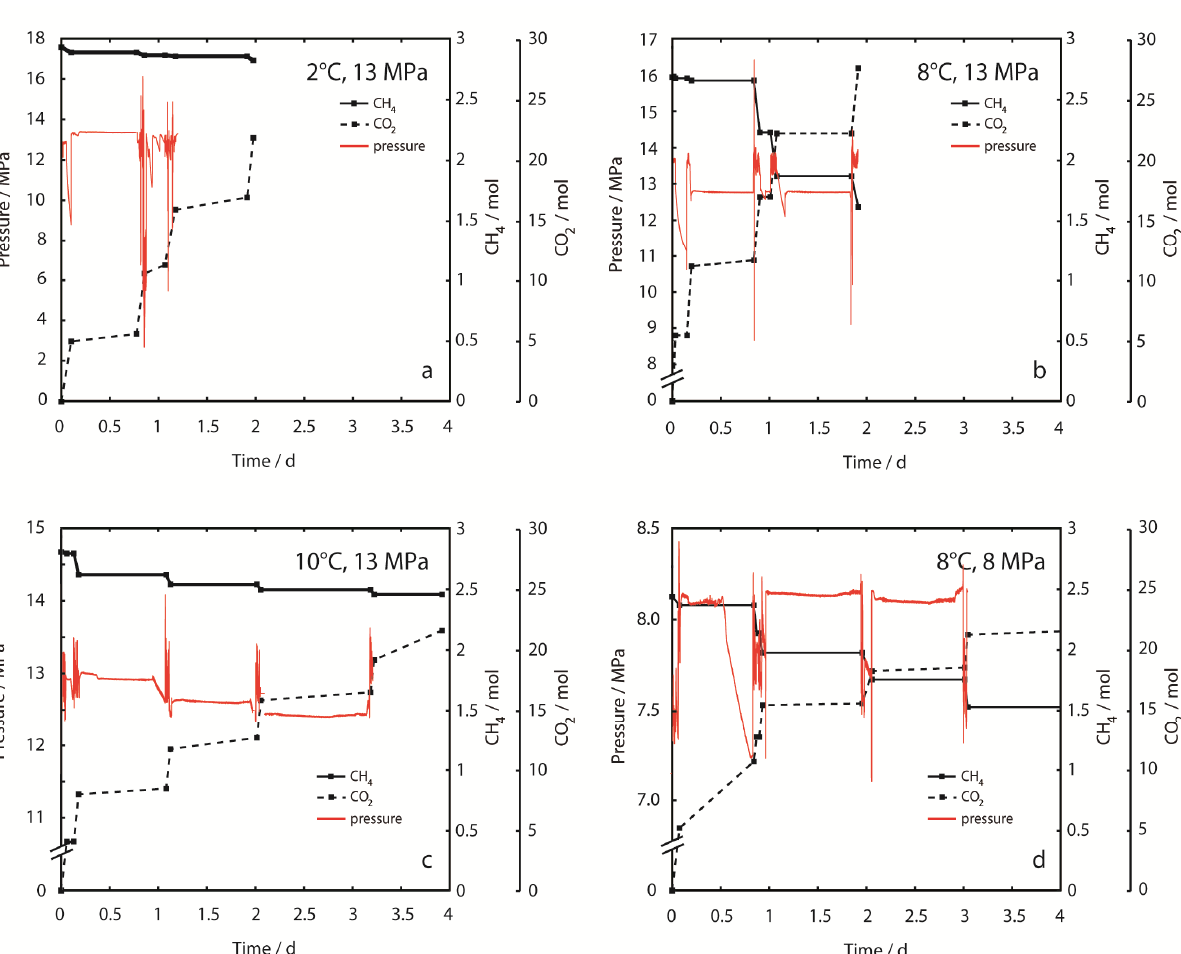
Figure 3. Inventory of CH , cumulative amount of injected CO and sample effluent pressure 4 2 ( p ) in each of the experimental runs. ( a ) 2 °C, 13 MPa; ( b ) 8 °C, 13 MPa; ( c ) 10 °C, effl 13 MPa; ( d ) 8 °C, 8 MPa. It should be noted, that the axis scaling for p is different for effl every experiment. CO was injected stepwise as hot supercritical CO and at a constant 2 2,sc flow rate (steep gradients in dashed lines). Injection of CO at constant pressure and low flow 2 rate alternated with equilibration periods. Fluids including CH could only exit the system 4 during injection/production periods. CH production is shown as a decrease of the CH 4 4 inventory. Effluent fluid pressure ( p ) is constant during equilibration periods. Strong effl aberrations indicate technical problems, which could be solved without destabilization of the hydrate sample. However, p is unstable during injection periods. Massive pressure spikes effl were observed in Experiment 1 (2 °C, 13 MPa) after sample permeability changed due to CO -hydrate formation. Sample permeability could be restored temporarily by fracturing at 2 high differential pressures (>15 MPa). CO -hydrate formation eventually led to complete 2 congestion of the fluid pathways at the end of the experiment. Sample blocking was not observed in other experiments at higher